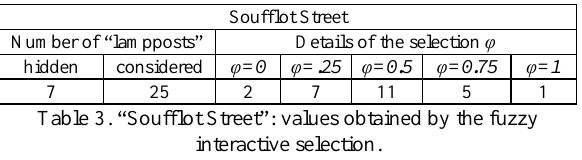
Table 3. “Soufflot Street”: values obtained by the fuzzy interactive